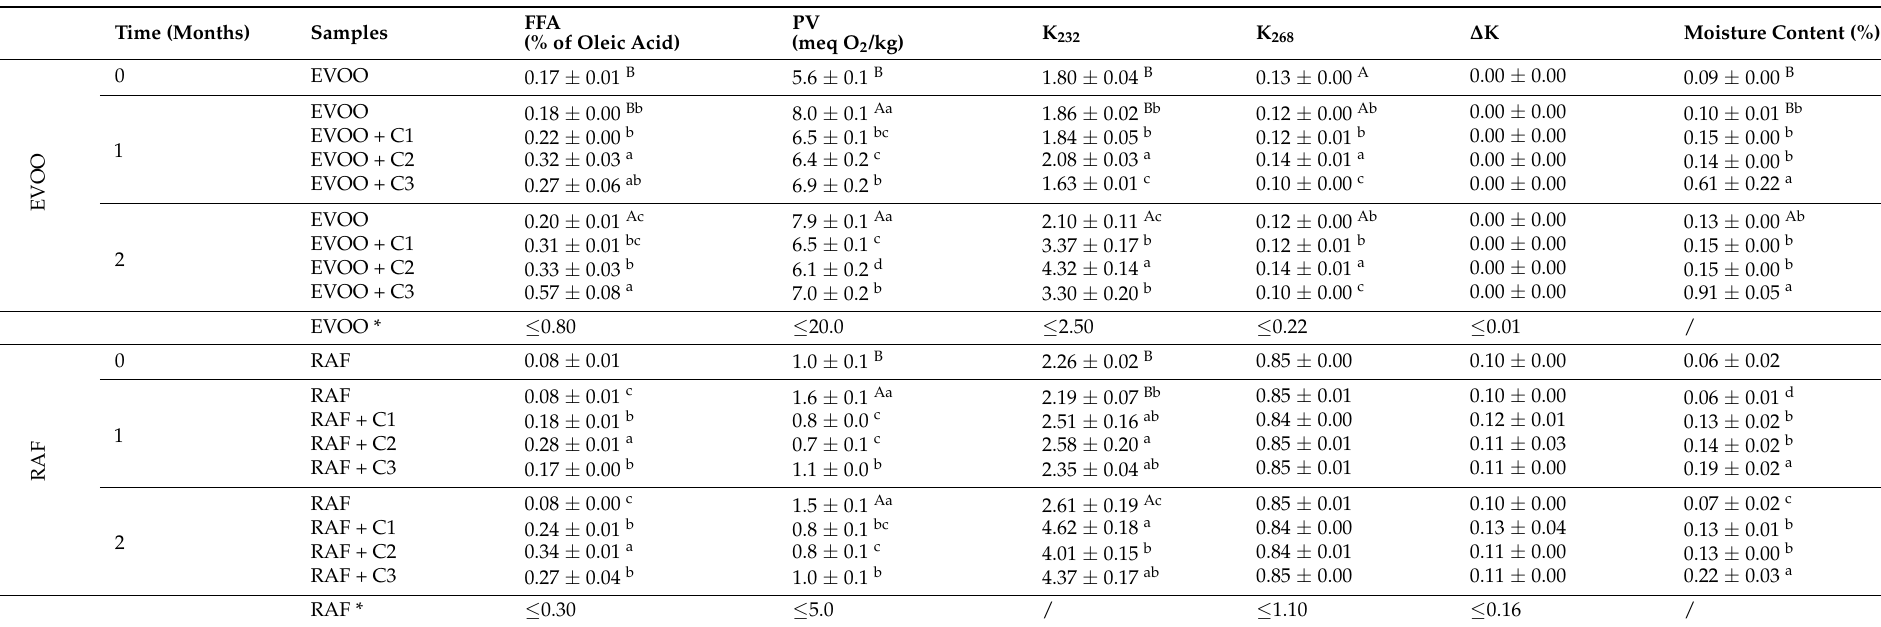
Results are expressed as mean values ± standard deviation of three independent repetitions. Mean values within the single oil type (EVOO or RAF) and the same storage time labeled by different small letters, as well as mean values of single oil type control samples at different storage time labeled by different capital letters, are statistically different (Tukey’s test, p < 0.05). * Actual limits for extra virgin olive oil category or refined olive oil category